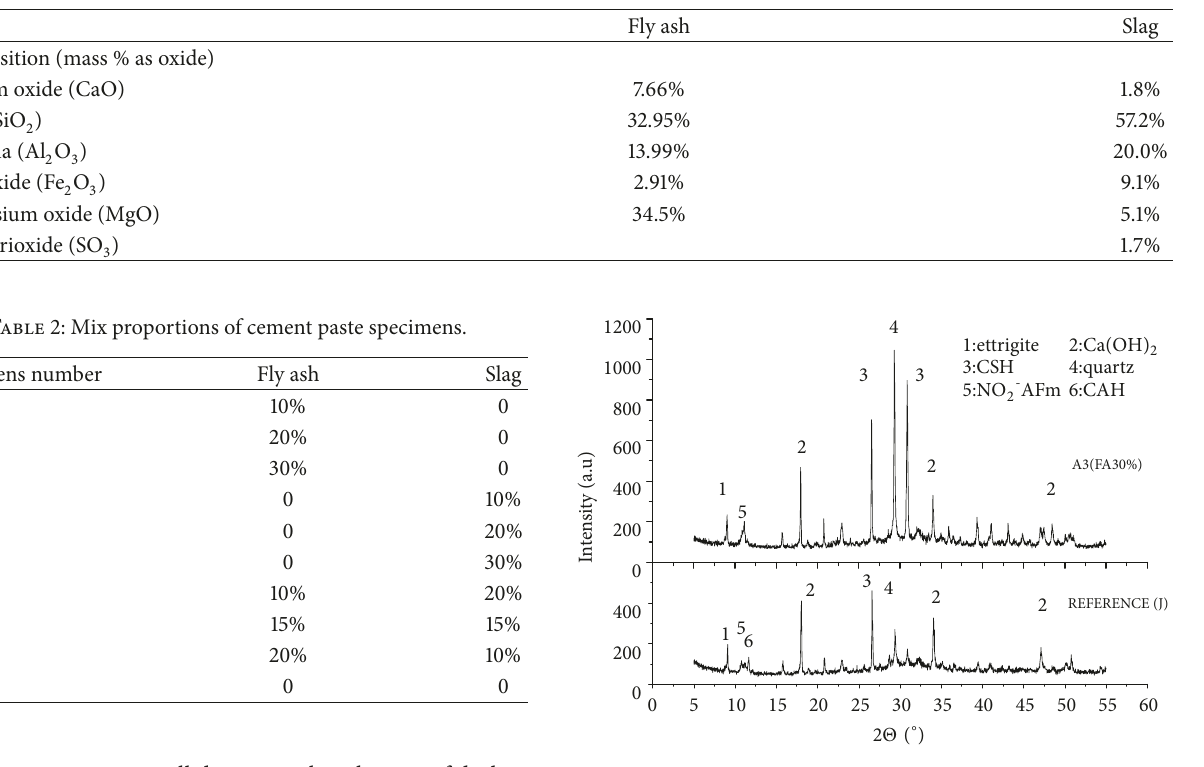
Figure 3: The X-ray diffraction pattern of the sample mixed with 30% single fly ash and the reference